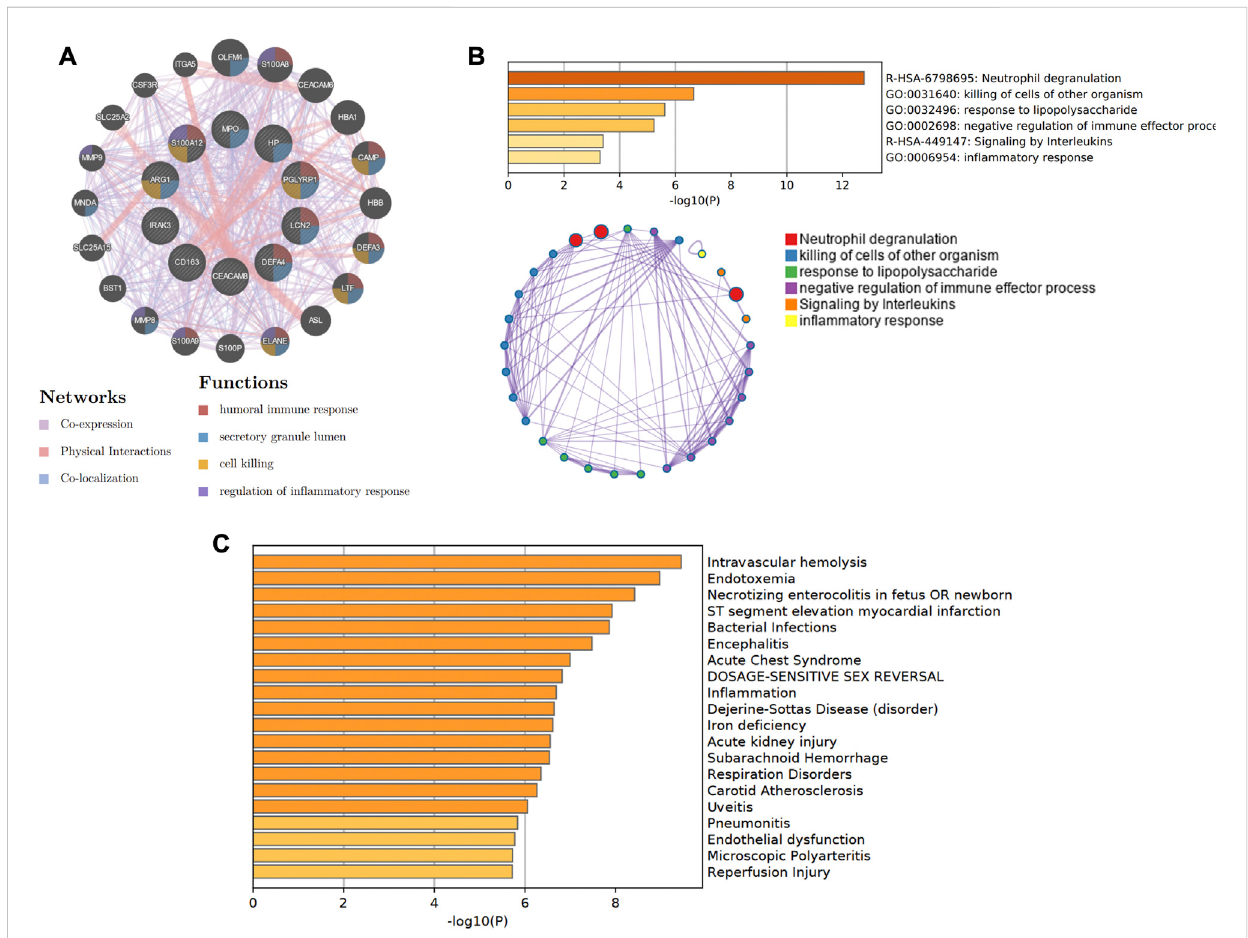
FIGURE 8 The co-expression network and biological functionsof hub genes. (A) Hubgenes and their co-expression genes were analyzed via GeneMANIA. (B) Thebiologicalpathwayswereenrichedforhubgenes via Metascape. (C) ThepotentialdiseaseswereparticipatedbythesehubgenesfromtheDisGeNET